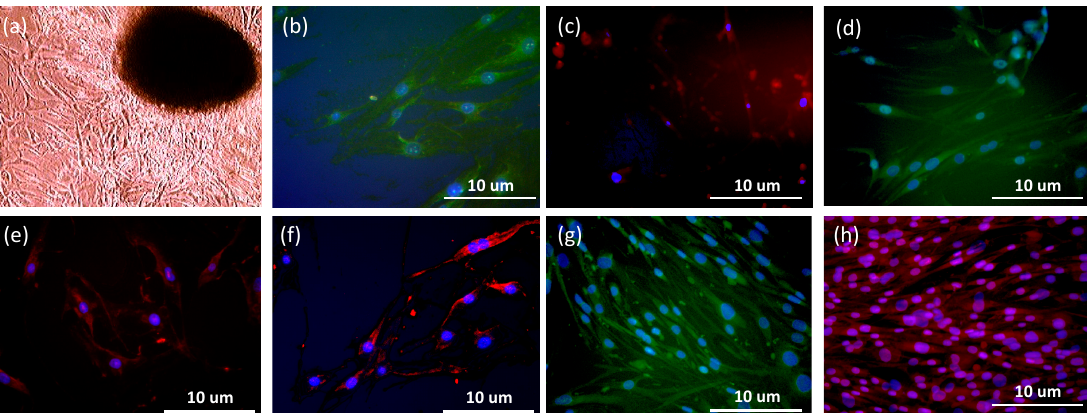
Figure 1. Characterization of the stemness and multilineage differentiation of human adipose stem cells (hASCs). The stemness of hASCs was characterized on the basis of several aspects: ( a ) sphere formation ability; ( b ) OCT-4 expression; ( c ) Nestin expression; ( d ) SOX-2 expression. However, multilineage differentiation of hASCs was assessed on the basis of the expression of the following markers: ( e ) NACM; ( f ) p75NTR; ( g ) Osteocalcin; ( h ) SOX-9. Nuclei counterstained with Hoechst 33342 are indicated in blue.